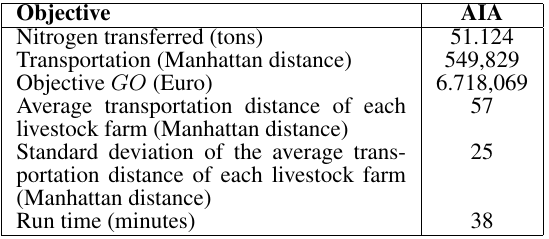
Table 2. Summarized values of the experiment performed, considering one complete